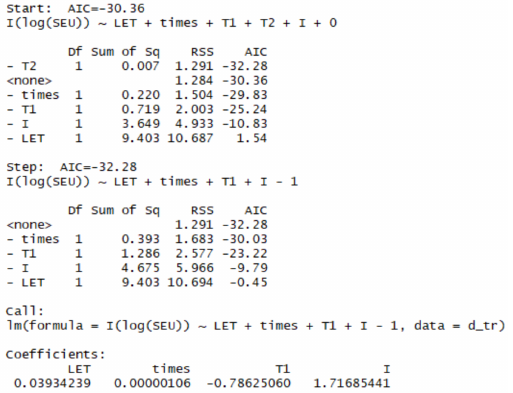
Figure 4. Variable selection using AIC criteria.